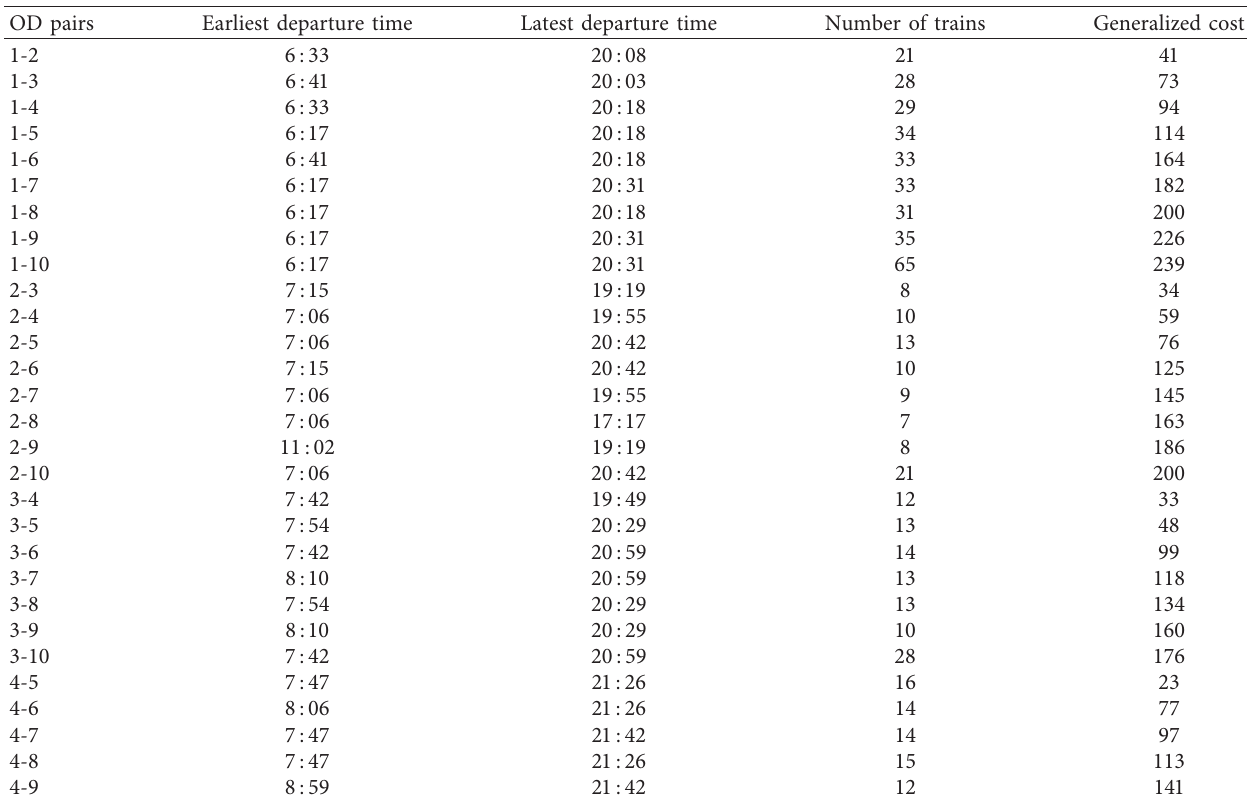
Table 8: Departure time and travel generalized cost for each OD